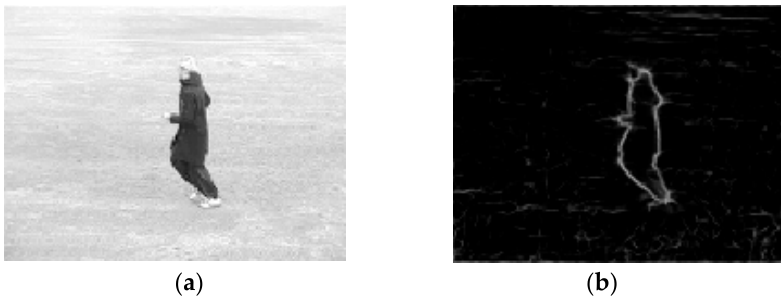
Figure 1. The 2D phase consistency processing. ( a ) Video frame; ( b ) 2D phase congruency (PC).